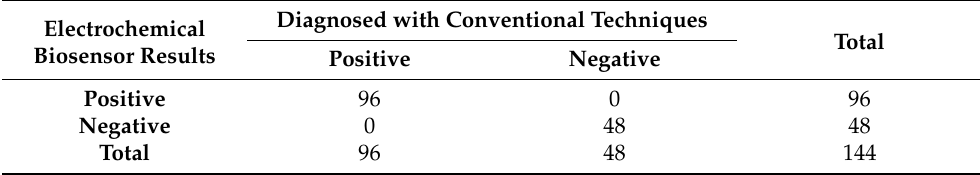
Table 2. Summary of diagnostic evaluation of the dengue IgM electrochemical biosensor using real serum samples. Electrochemical Biosensor